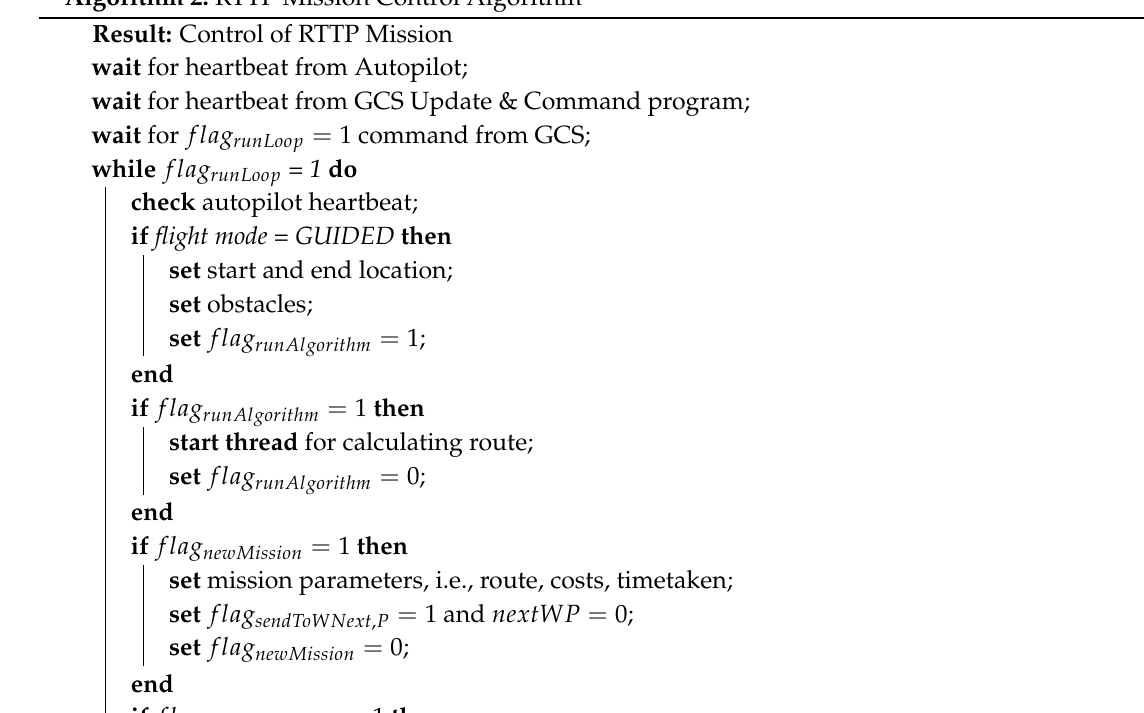
Algorithm 2: RTTP Mission Control